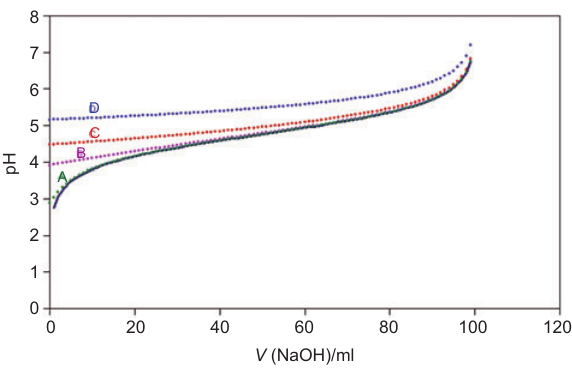
Figure 1 Curve for the titration of acetic acid with sodium hydrox- ide. Curve A: 0.1 M acid with 0.1 M base. Curve B: 1 × 10 -3 M acid with 1 × 10 -3 M base. Curve C: 1 × 10 -4 M acid with 1 × 10 -4 M base. Curve D: 1 × 10 -5 M acid with 1 × 10 -5 M base. Before equivalence point: full line, Eq. (8); dotted lines, Eq.